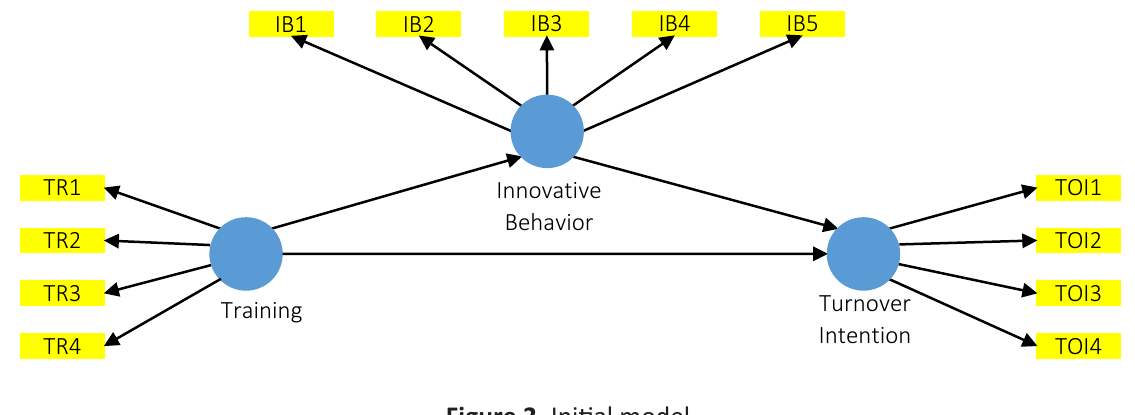
Figure 2. Initial